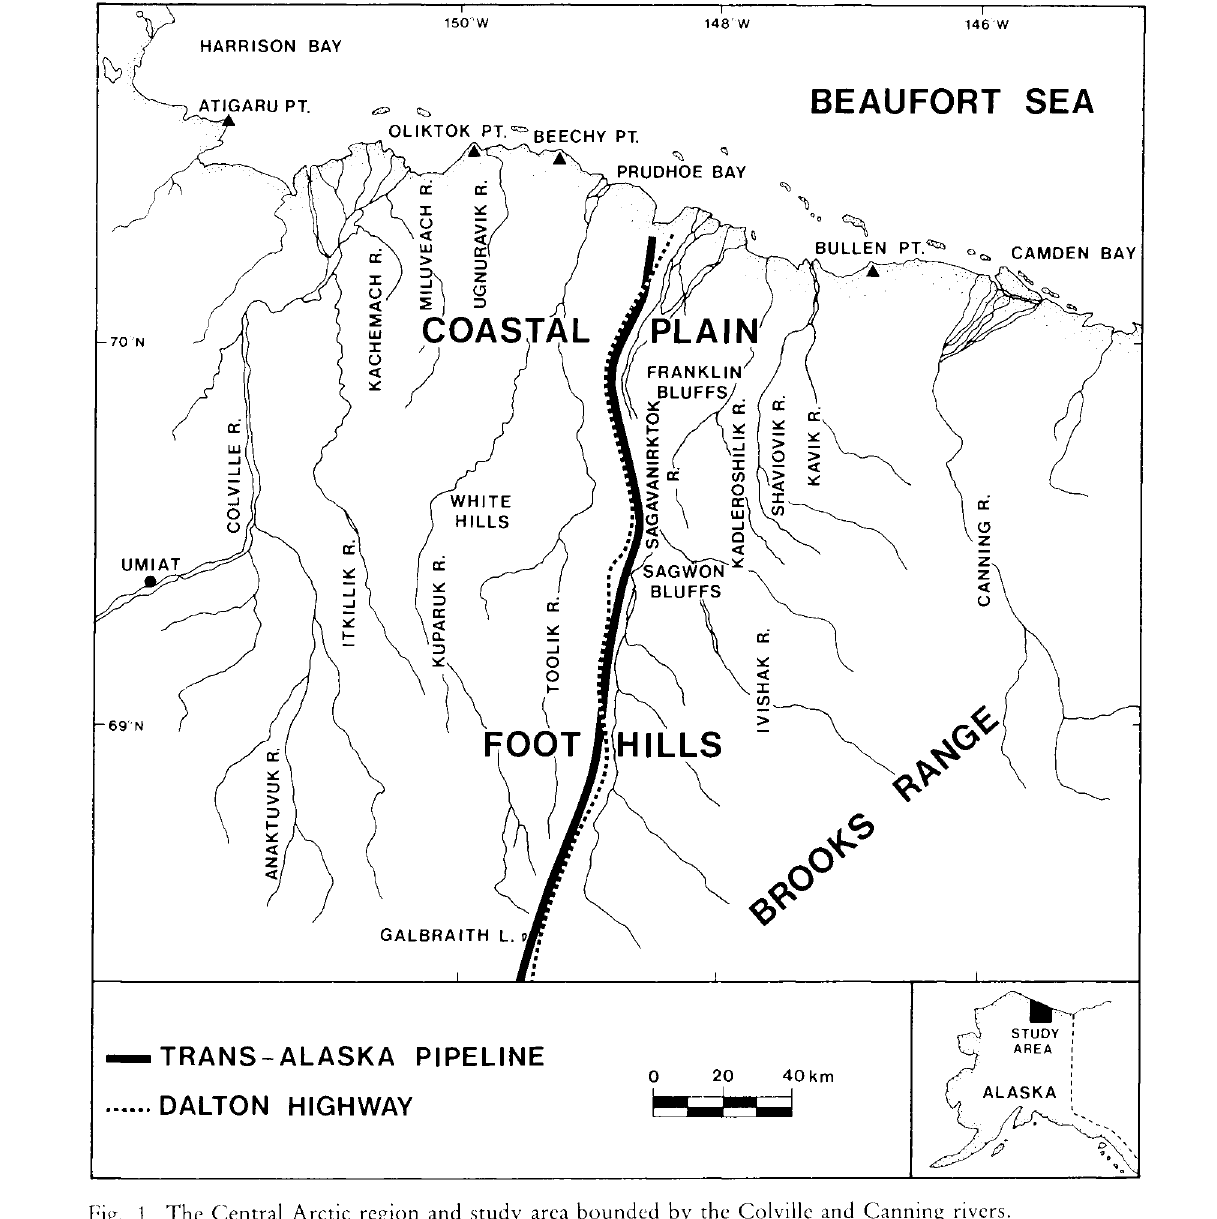
Fig. 1. The Central Arctic region and study area bounded by the Colville and Canning